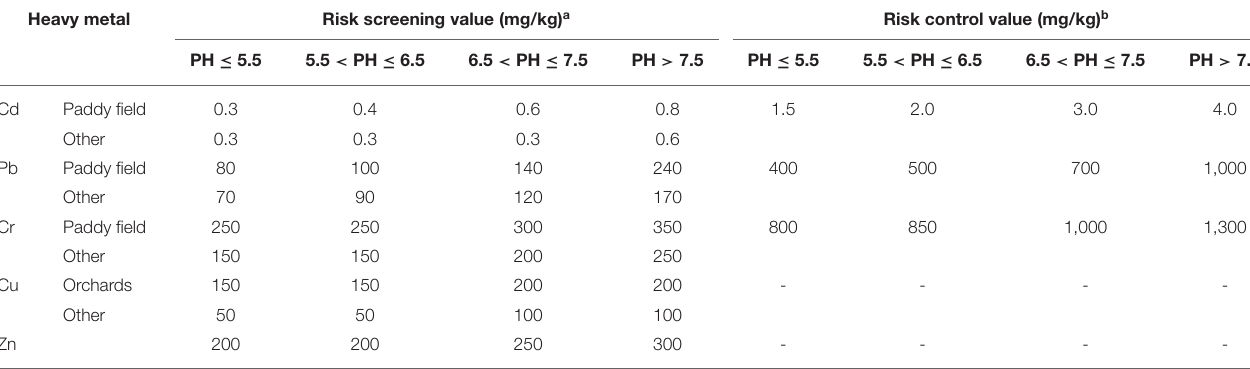
TABLE 2 | Risk control standard for soil contamination of agricultural land (GB 15618-2018). Heavy